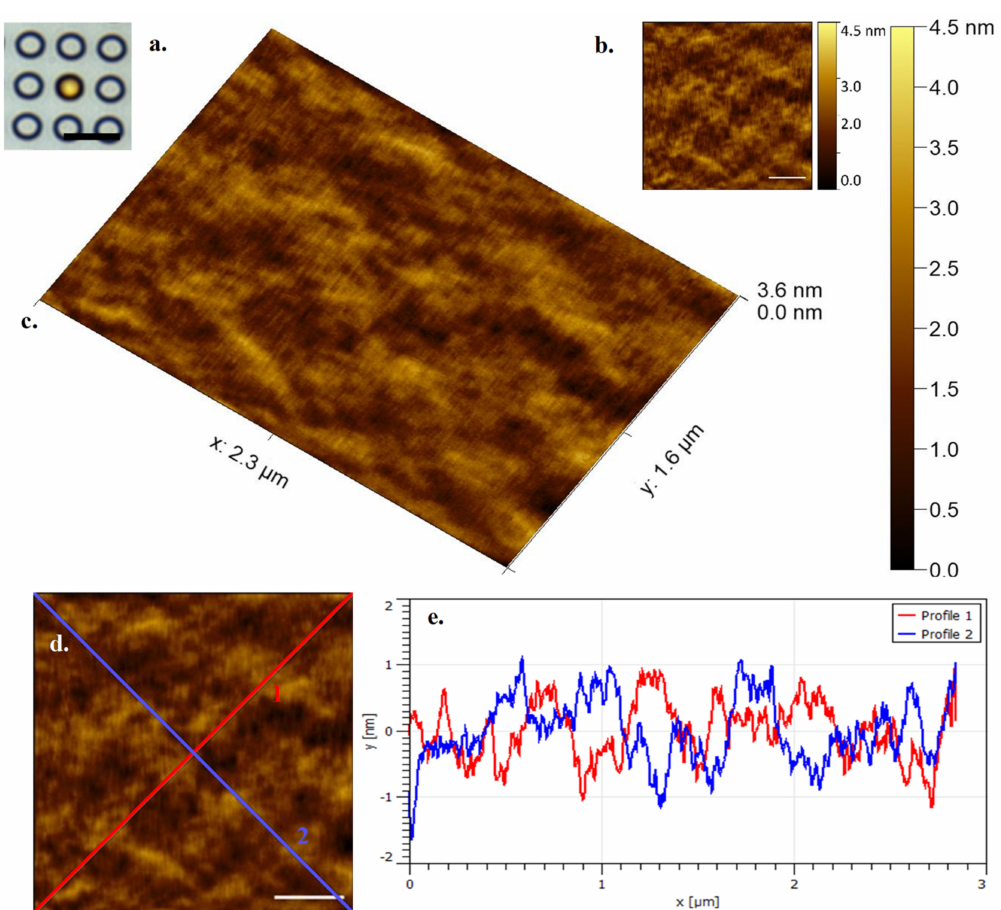
Figure 4. ( a ). (Inset left) E. huxleyi cell visualised by optical microscopy at × 63 obj (Cyl 5) (Scale bar 10 µ m) ( b ). (Inset right) HS-AFM data seen in Figure 4c (Scale bar 500 nm) ( c ). E. huxleyi cell visualised by HS-AFM in liquid (3D render, data captured at 2 fps) ( d ). Diagonal transects (Scale bar 500 nm) ( e ) Diagonal transects marked in Figure 4d showing E. huxleyi surface